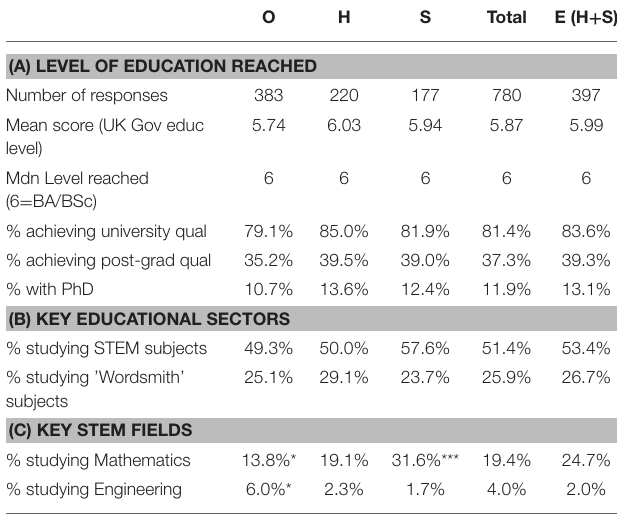
TABLE 2 | Hours spent on (A) solving and (B) other crossword related activities. O H S All Groups